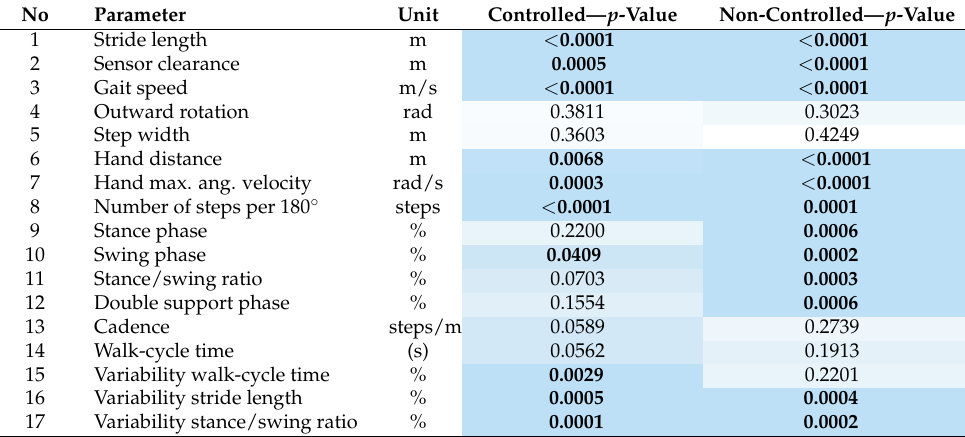
Table 2. Results from the Mann–Whitney U-test comparing the gait parameters of normal pressure hydrocephalus (NPH) patients and the healthy elderly control group (EHC). Significant results are indicated in bold, with blue representing values closer to 0 and white representing values closer to